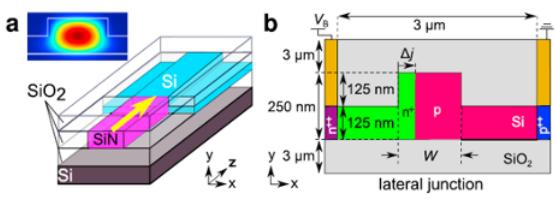
Fig. 3. The on-chip silicon APD designed for visible light. An end-fire coupling scheme in (a) is used to couple the input SiN waveguide with the Si rib waveguide that is n+ and p doped to form an integrated silicon photodetector in (b) .